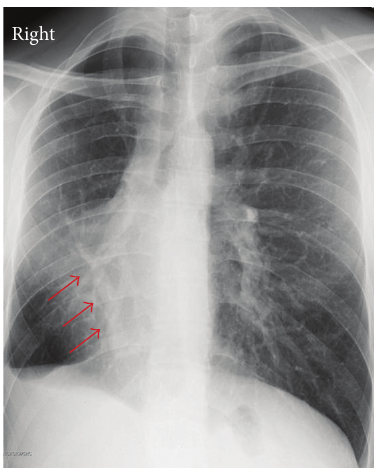
Figure 2: Chest radiograph shows decreased space associated with the hypoplastic lung and displacement of the cardiac silhouette to the right (scimitar sign) (arrows).